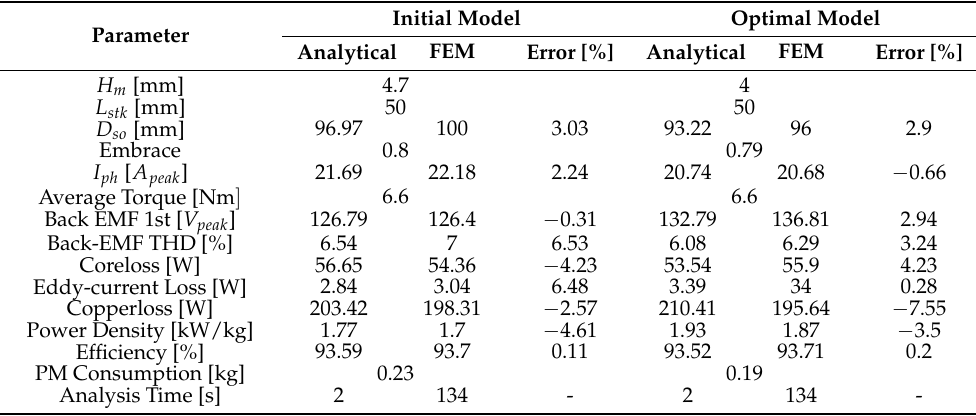
Table 2. Optimal Model Results Comparison with